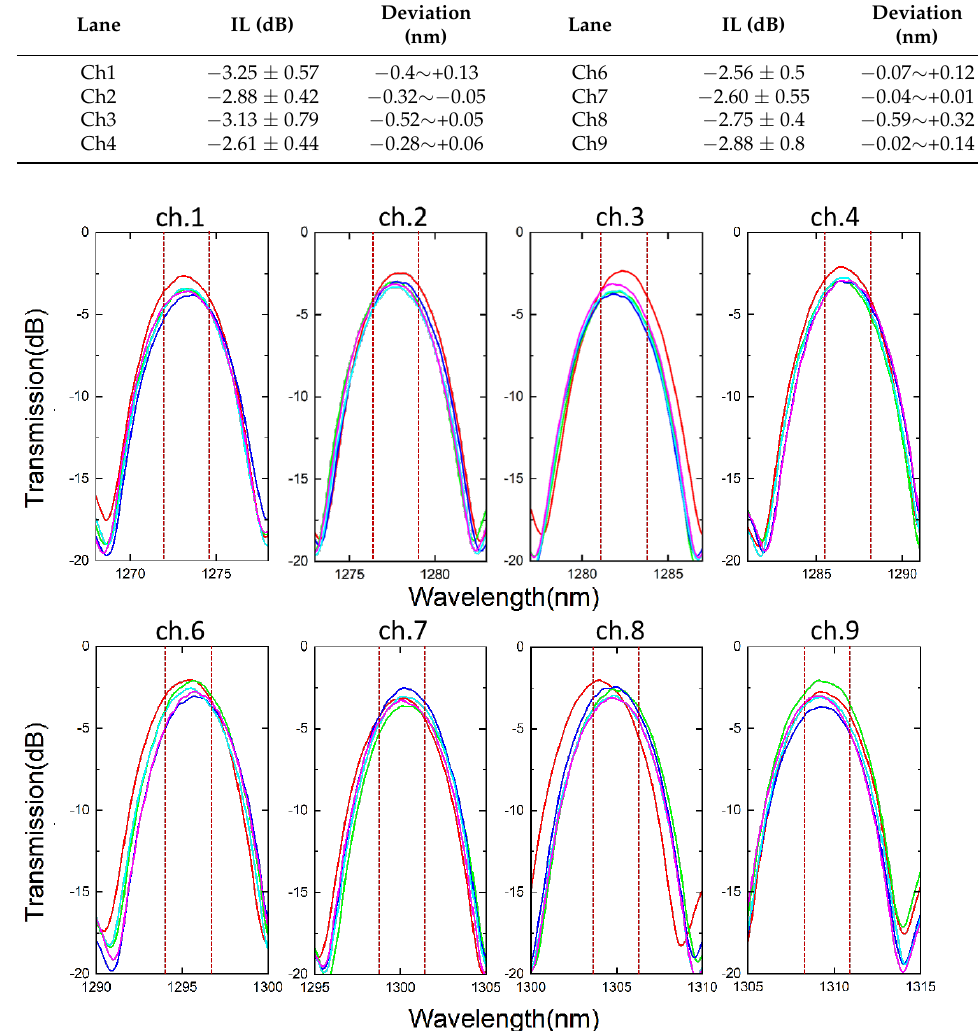
Figure 7. Measured transmission of five 8-channel (de)multiplexer across an 8-inch wafer. The range between the red dotted lines is the wavelength range of each